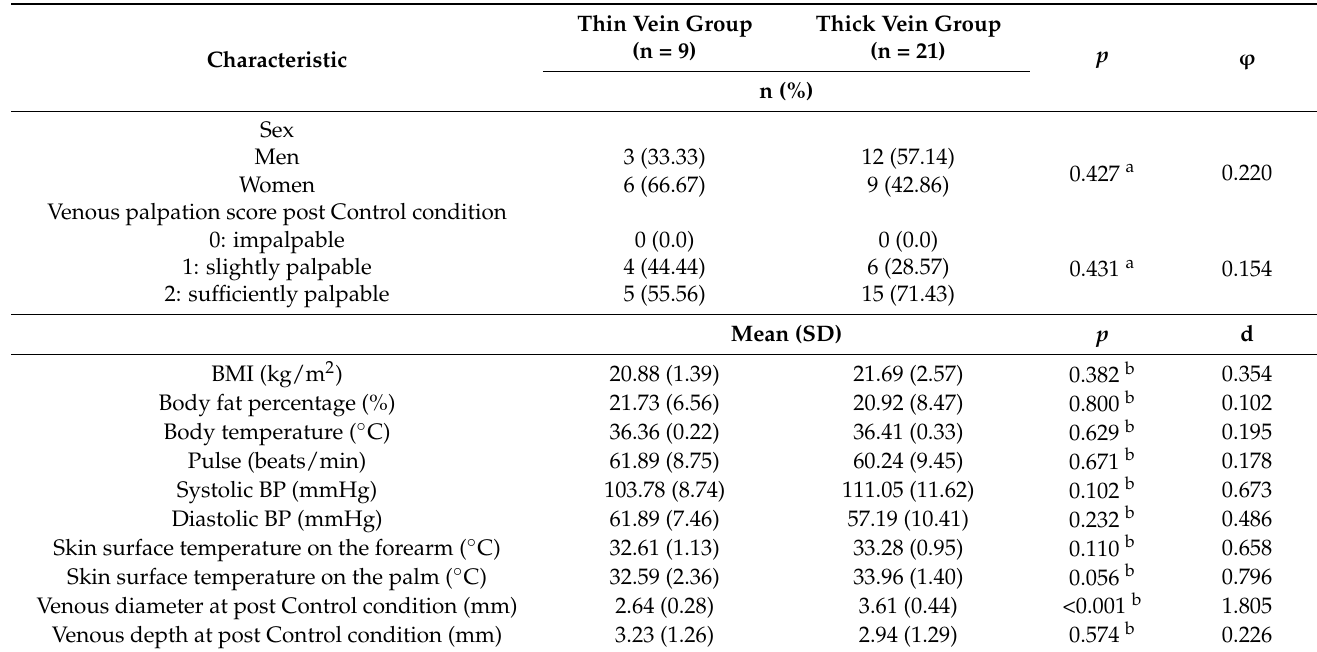
Table 4. Differences in participants’ characteristics between venous sizes (n = 30).